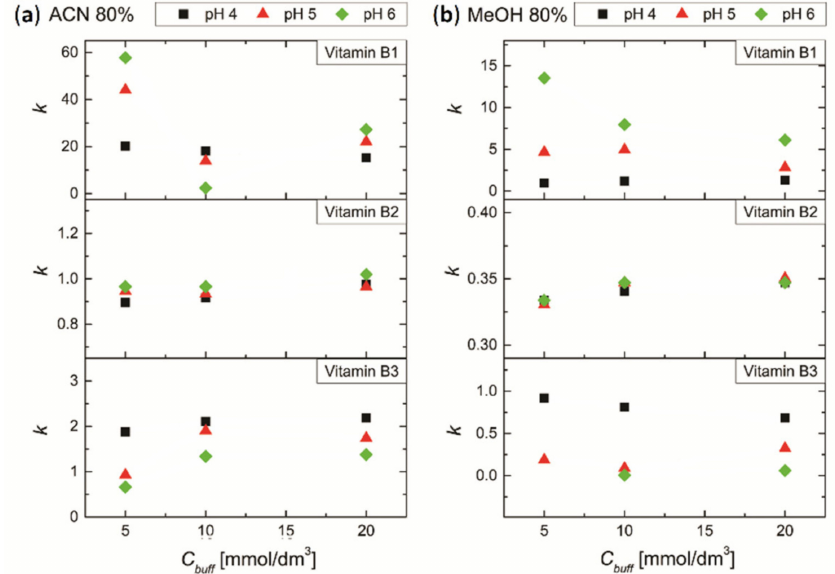
Figure 12. Effect of buffer pH and concentration on retention of vitamins in column E (Eurospher II